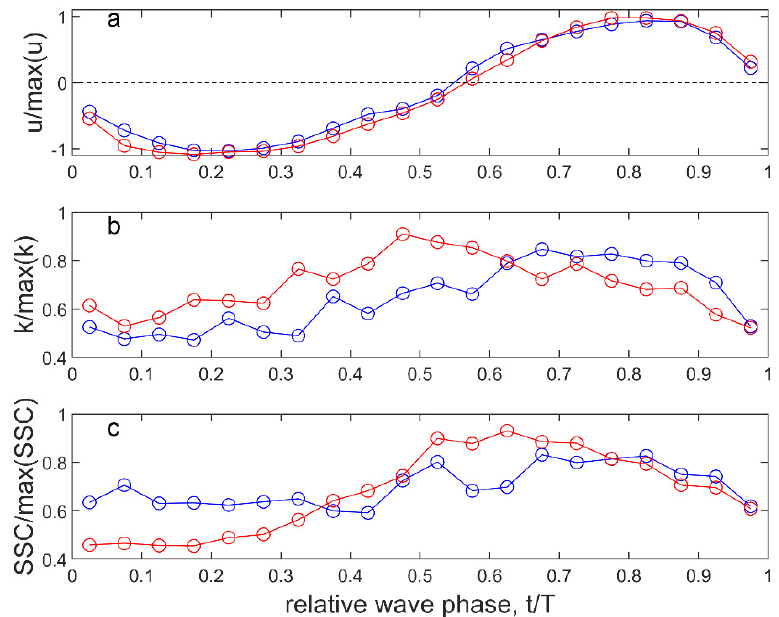
Figure 16. Ensemble-averaged measurements of normalized ( a ) cross-shore velocity, ( b ) turbulent kinetic energy, and ( c ) SSC for predominantly spilling (blue lines) and plunging (red lines) breakers at z = 0.05 m. Data were combined from six time series, comprising three series with mainly plunging breakers and three series with spilling breakers. Reproduced from Aagaard et al. [72].